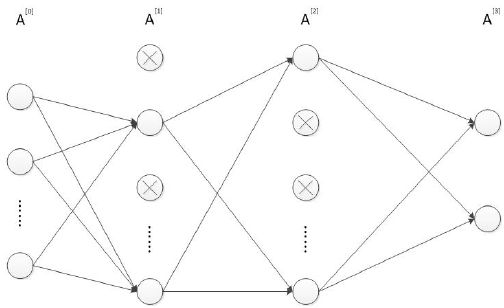
Figure 1. The structure of the MLP network.